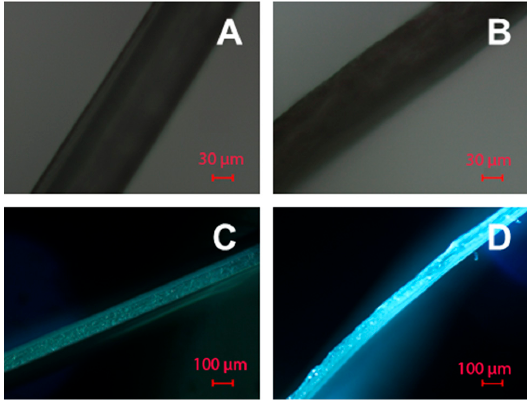
Figure 3. The images of the cuts of modified PLA films obtained by optical microscopy: ( A , B ) PLA-PAAm and PLA-Alg in transmitted light; ( C , D ) PLA-PAAm and PLA-Alg in reflected light. Table 1. The thickness of dry films and their swelling depending on initial monomer/polymer concentration.